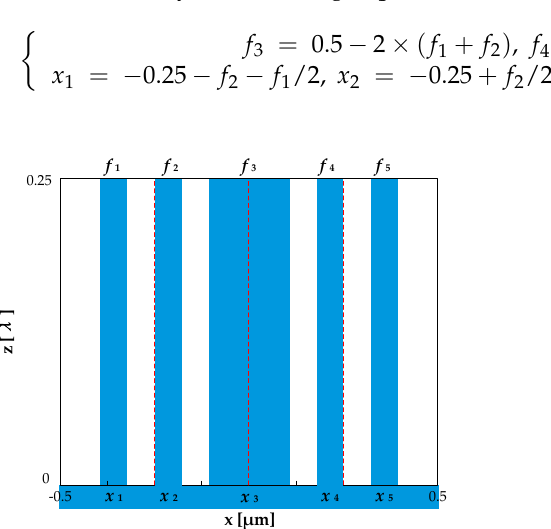
According to Equation (10), the diffraction efficiency is expressed as: